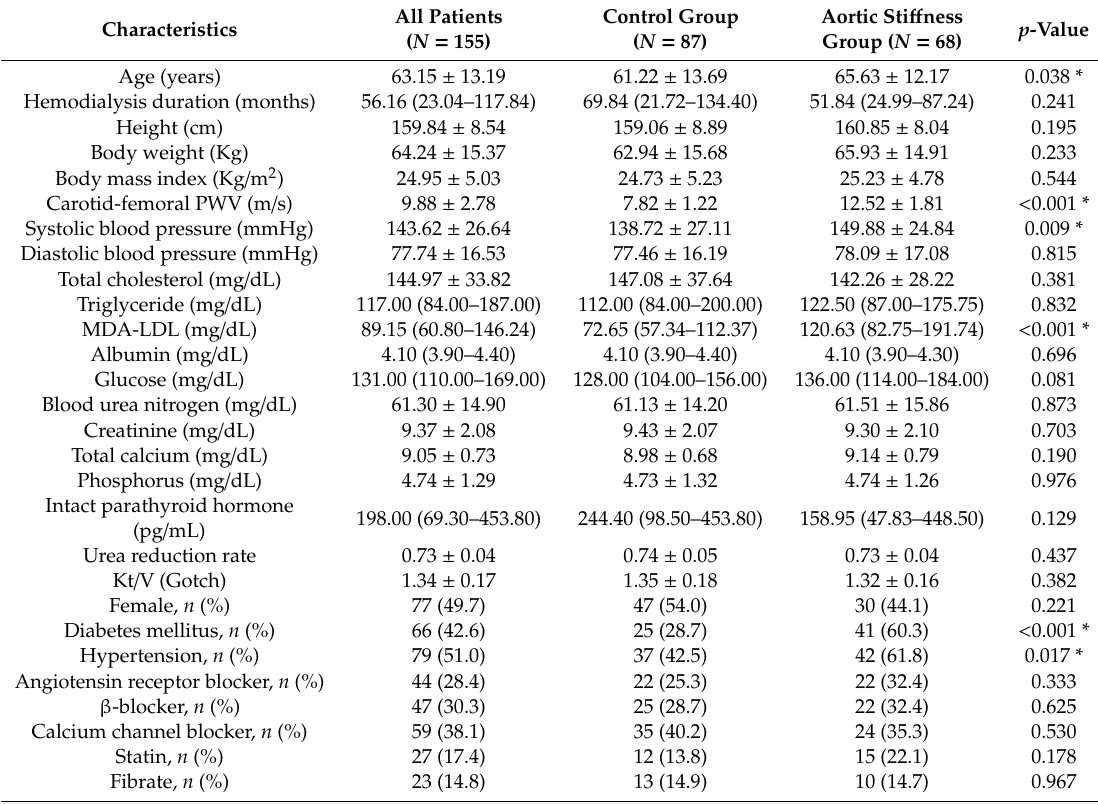
Table 1. Clinical variables of the 155 hemodialysis (HD) patients with or without aortic sti ff ness (AS). Characteristics